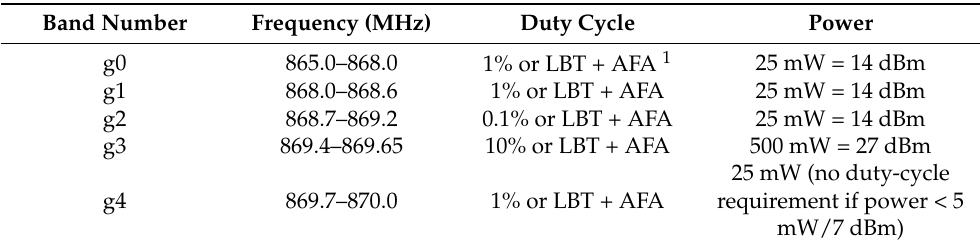
Table 2. Bands and regulations according to the European Reseach Council (ERC) Recommendation 70-03 and LoRaWAN Specifications [20–23].